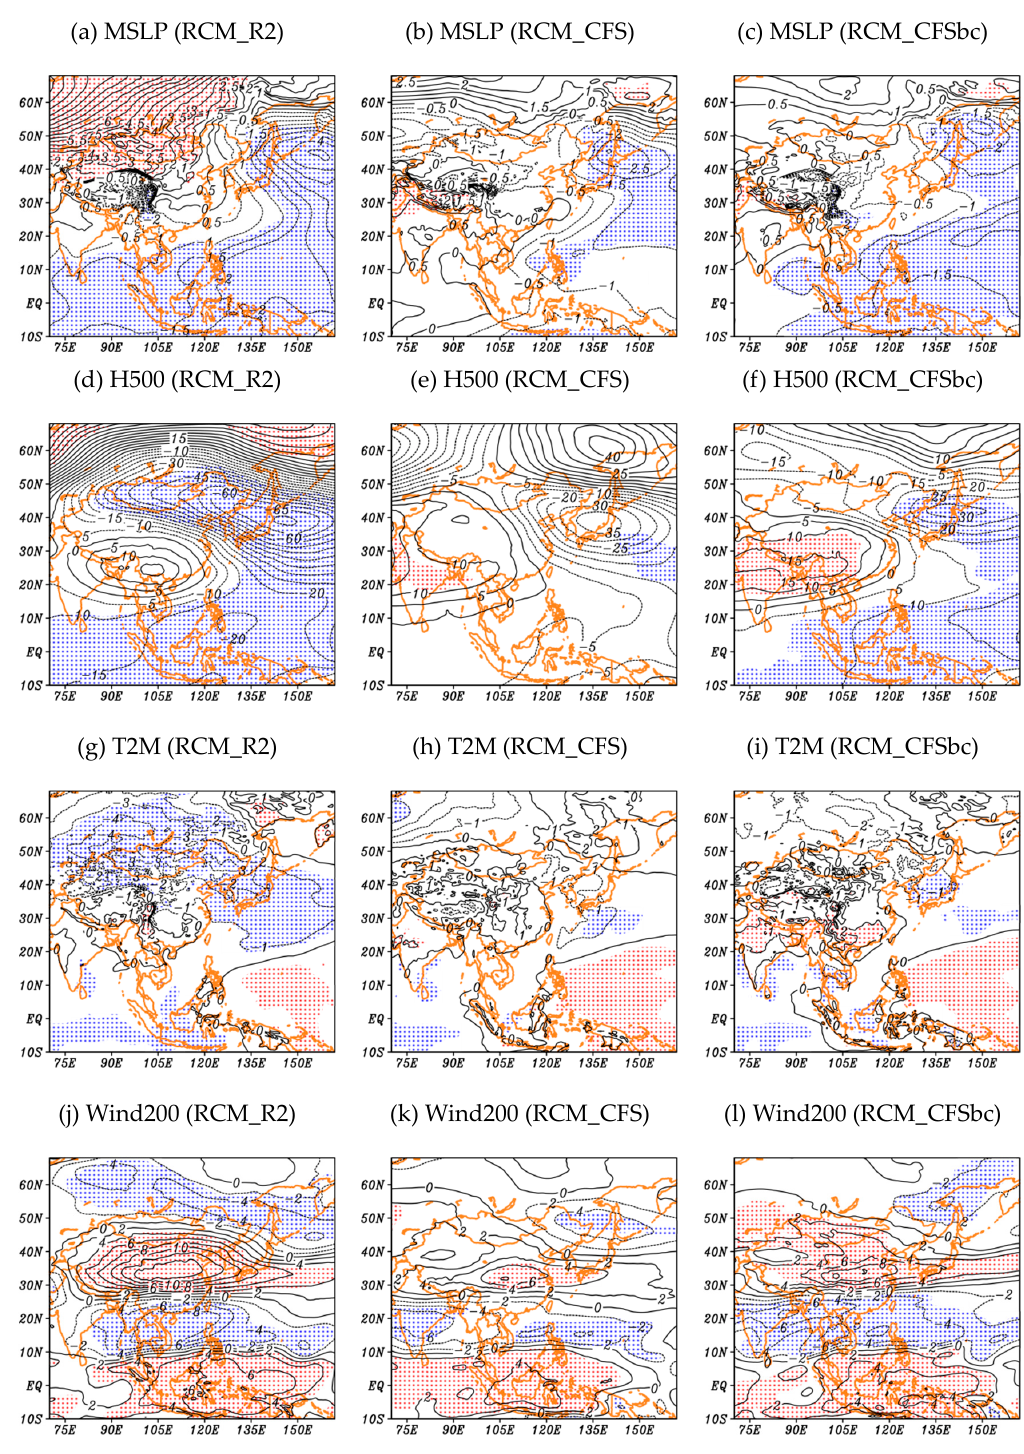
Figure 8. Composite difference distribution (strong–weak monsoon years) of the ( a )–( c ) mean sea level pressure, ( d )–( f ) 500 hPa geopotential height, ( g )–( i ) 2 m temperature, and ( j )–( l ) 200 hPa wind magnitude for RCM_R2 (left), RCM_CFS (center), and RCM_CFSbc (right) experiments . Stippled areas indicate significance at the 95% confidence levels (positive value is red, and negative value is blue).